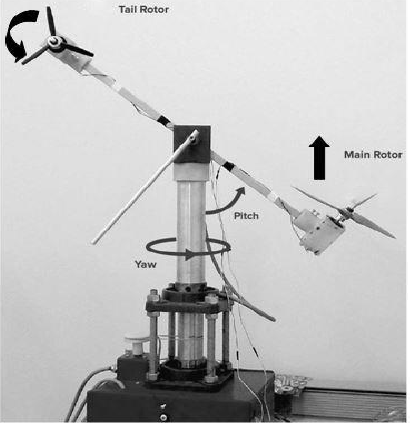
Fig. 1. The twin rotor system in our